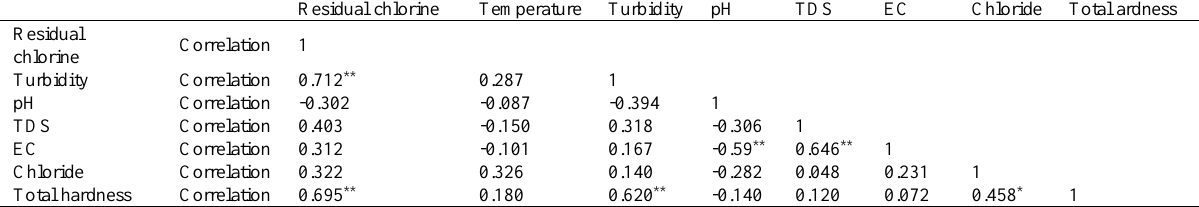
Table 5. Correlation matrix of studied parameters based on distribution networks (*P<0.01) Residual chlorine Temperature Turbidity pH TDS EC Chloride Total ardness Residual Correlation 1 chlorine Turbidity Correlation 0.712 ** 0.287 1 pH Correlation -0.302 -0.087 -0.394 1 TDS Correlation 0.403 -0.150 0.318 -0.306 1 EC Correlation 0.312 -0.101 0.167 -0.59 ** 0.646 ** 1 Chloride Correlation 0.322 0.326 0.140 -0.282 0.048 0.231 1 Total hardness Correlation 0.695 ** 0.180 0.620 ** -0.140 0.120 0.072 0.458 *